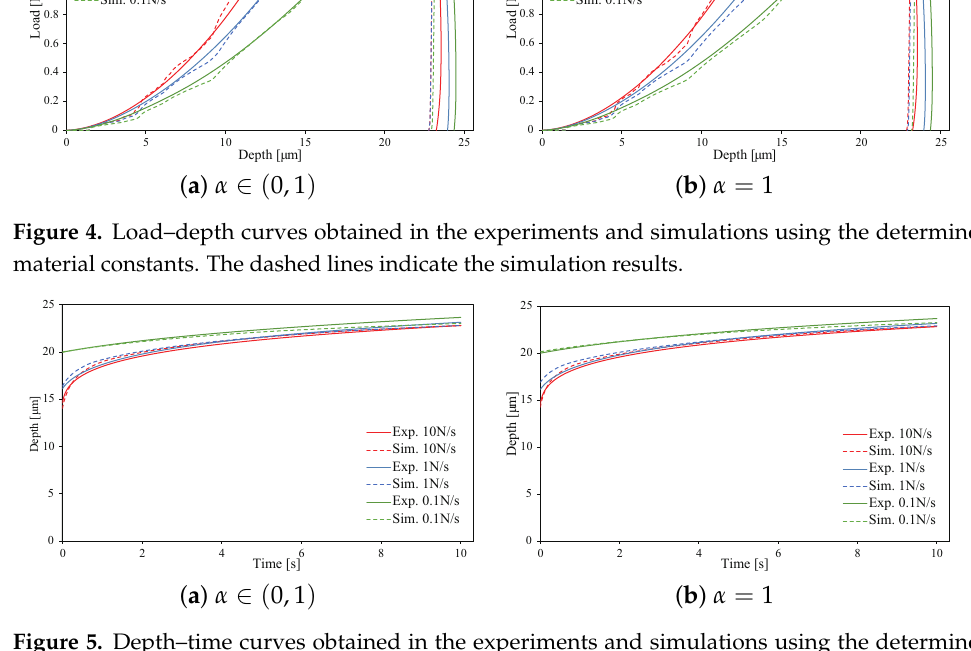
Figure 5. Depth–time curves obtained in the experiments and simulations using the determined material constants. The dashed lines indicate the simulation results.